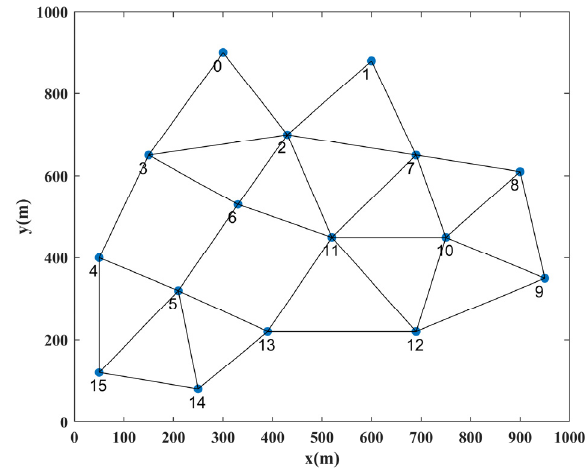
Figure 5. Distribution of